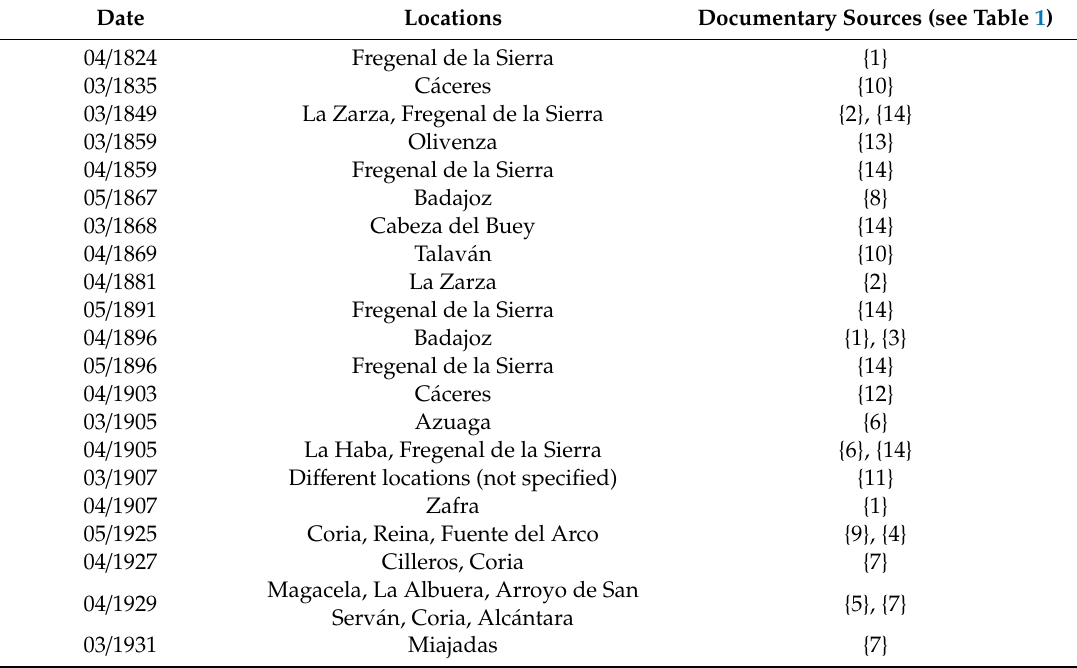
Table 2. 21 dates of spring rogation ceremonies and the principal data of them.